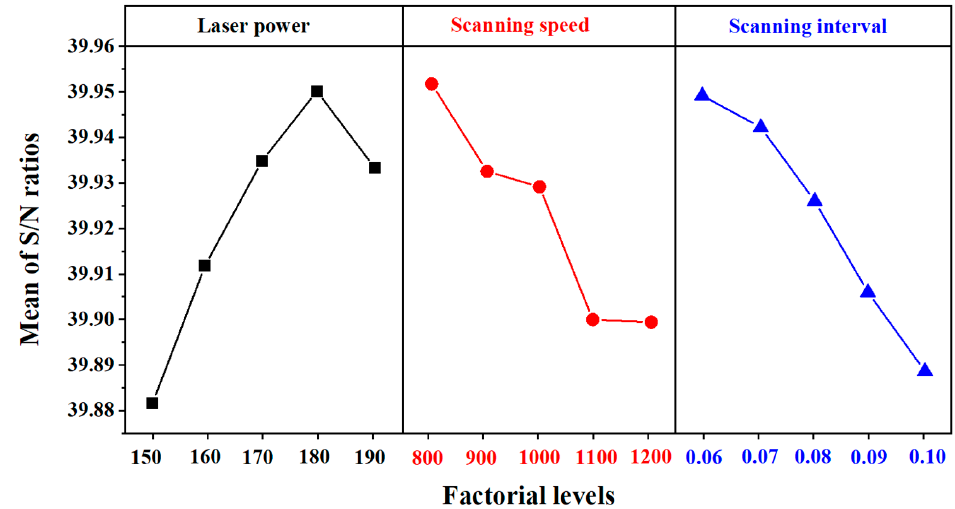
Figure 6. Main effect plots of S/N ratio—relative density.